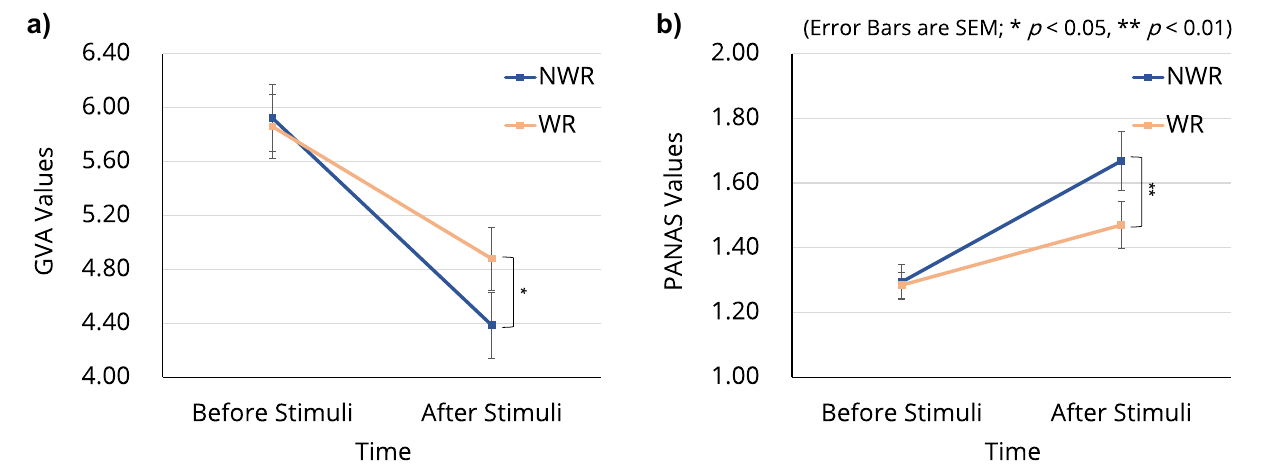
Figure 6. Psychological state of participants during the experiment. ( a ) Happiness state of GVA measured before and after each thermal stimulation. ( b ) Negative psychological state measured using the PANAS before and after each thermal